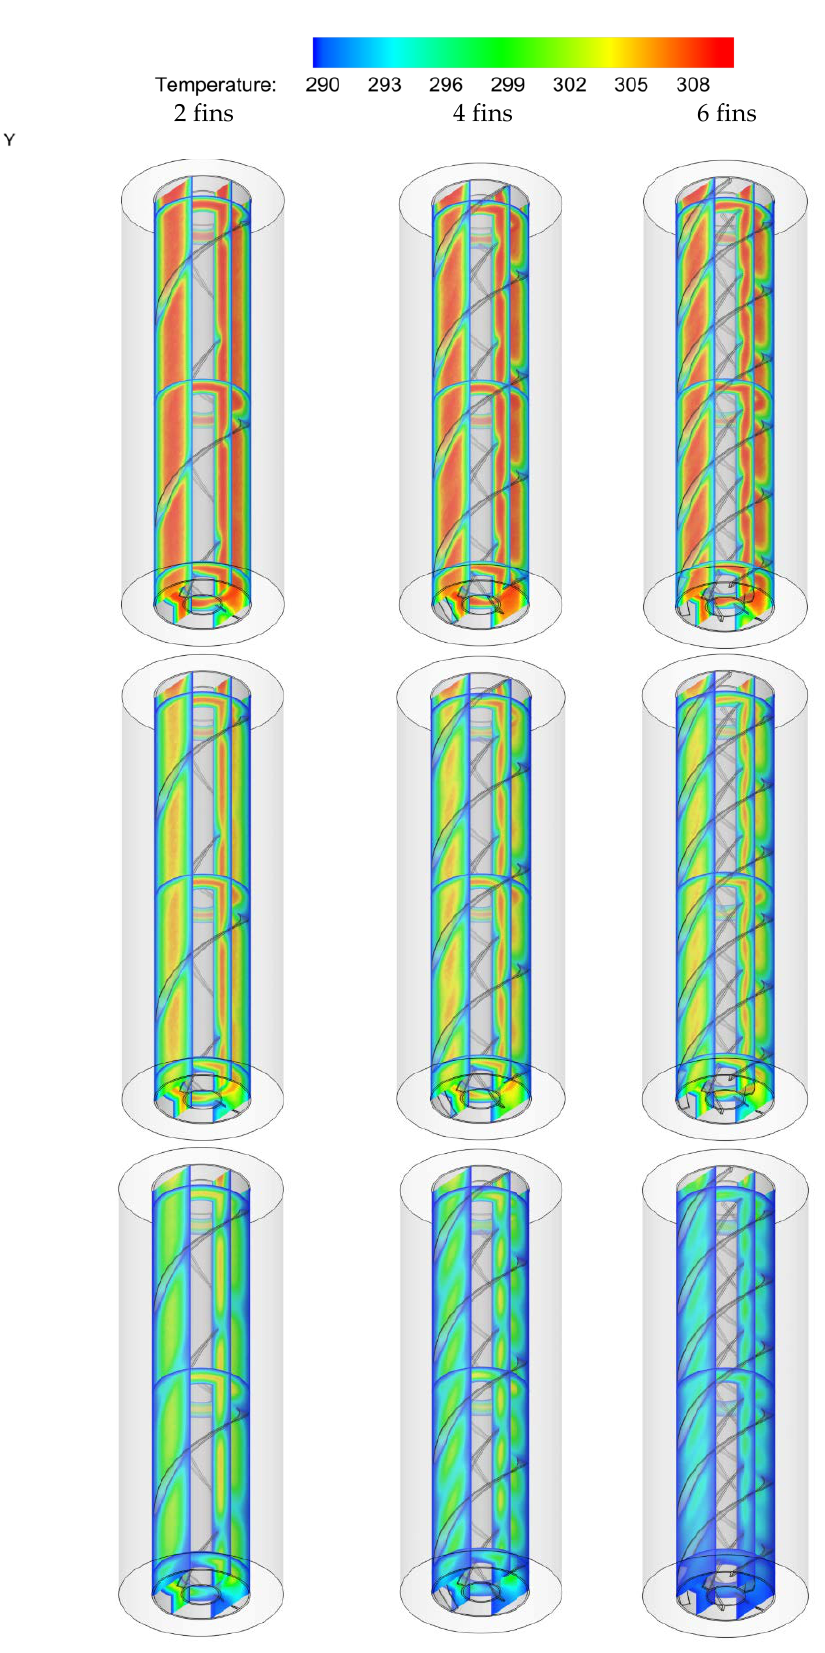
Figure 5. Evolution of temperature field for the three different cases of twisted fins at different time spans of solidification progress.